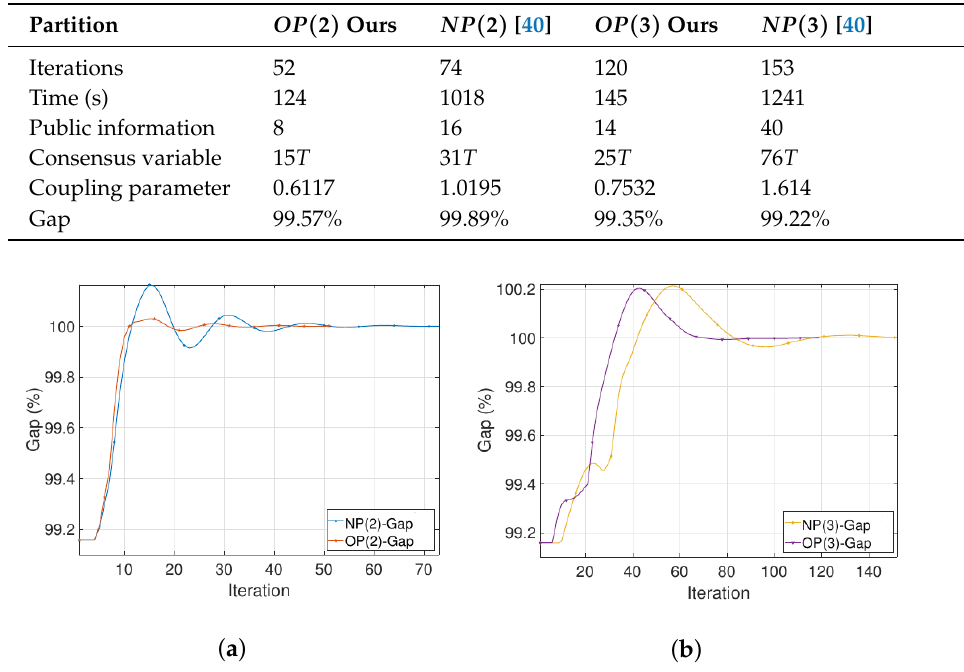
Table 3. Performance comparison among different partitions.